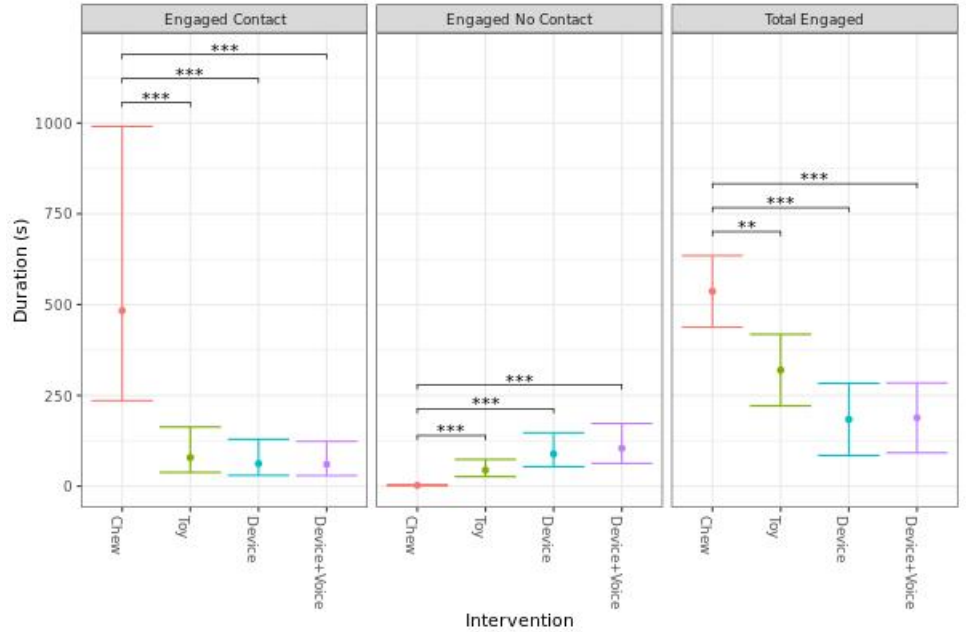
Figure 2. Predicted mean (95% CI) duration of time (s) dogs spent engaged with physical contact, engaged without physical contact, or total engagement (sum of engaged with and without physical contact) when left alone with one of four enrichments for 20 min. Asterisks indicate significant differences between treatment groups. Three asterisks indicate significance at p < 0.001, two asterisks indicate significance at p <